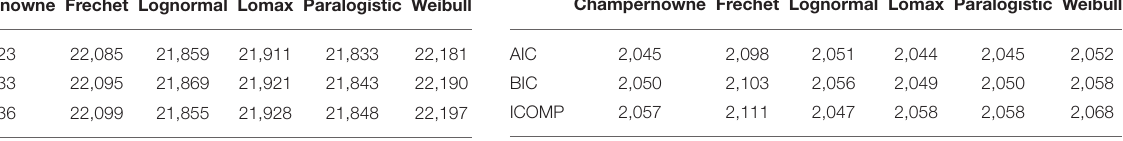
TABLE 7 | Simulation: Information criteria for Champernowne, Frechet, Lognormal, Lomax, Paralogistic, and Weibull models. Champernowne Frechet Lognormal Lomax Paralogistic Weibull